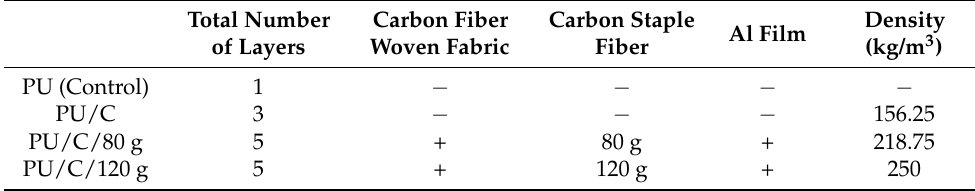
Figure 1. The manufacturing process of PU foam composite planks. Figure 1. T he manufacturing process of PU foam composite planks Table 1. The composition of the PU foam composite Table 1. The composition of the PU foam composite planks.